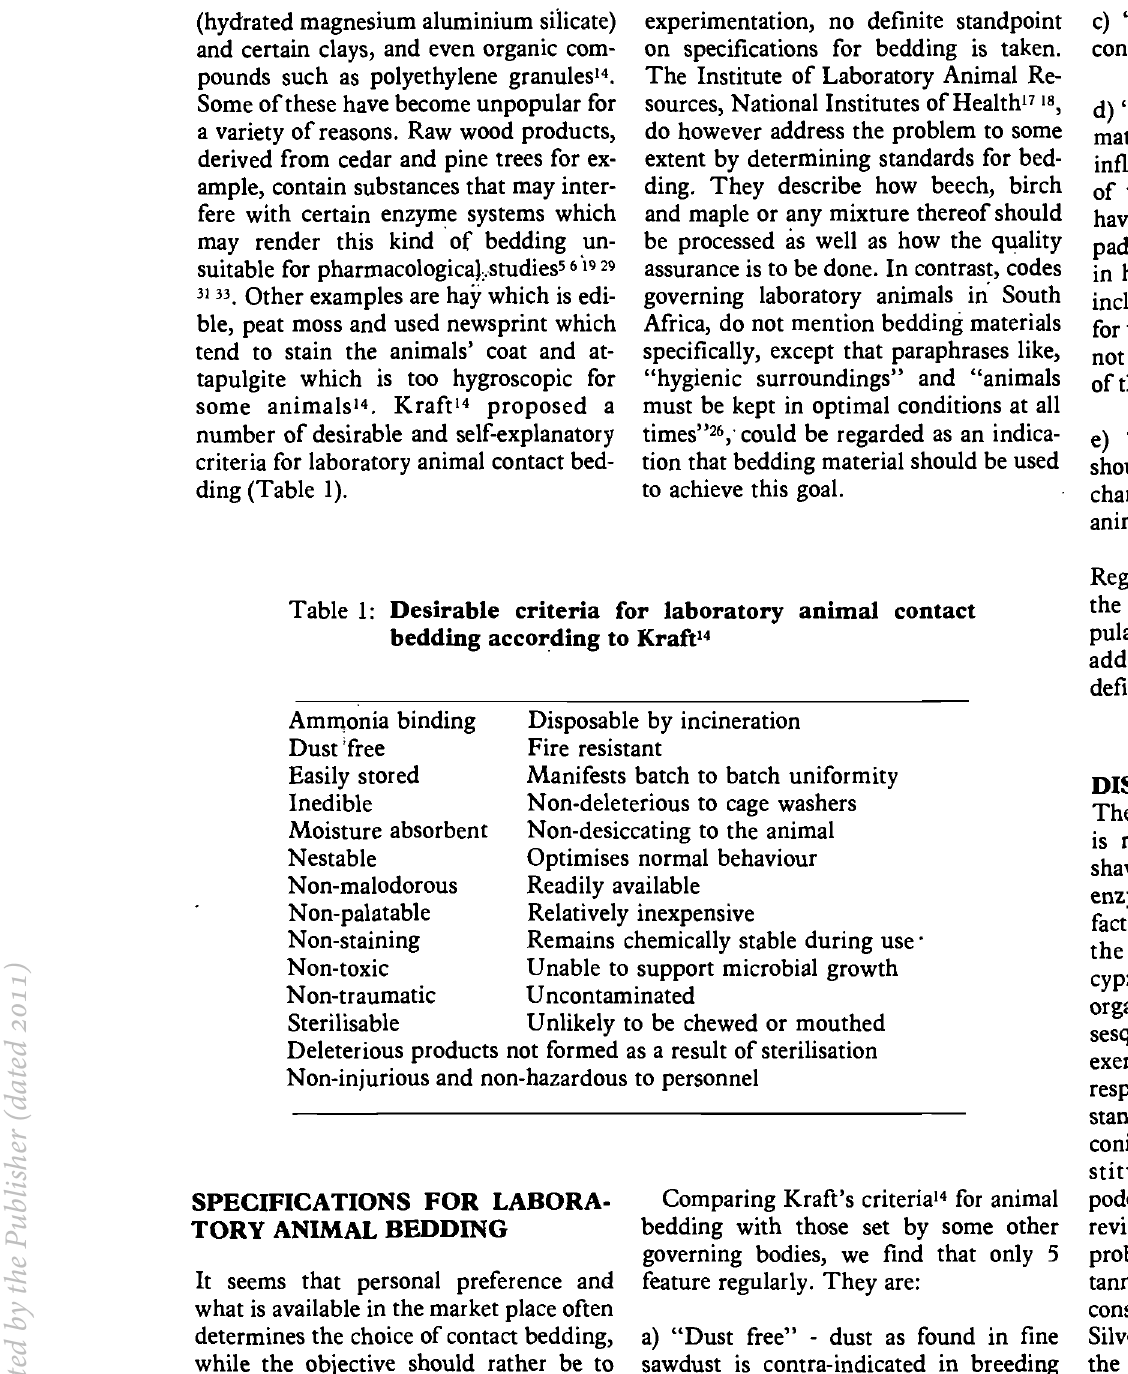
Table 1: Desirable criteria for laboratory animal contact bedding according to Kraft